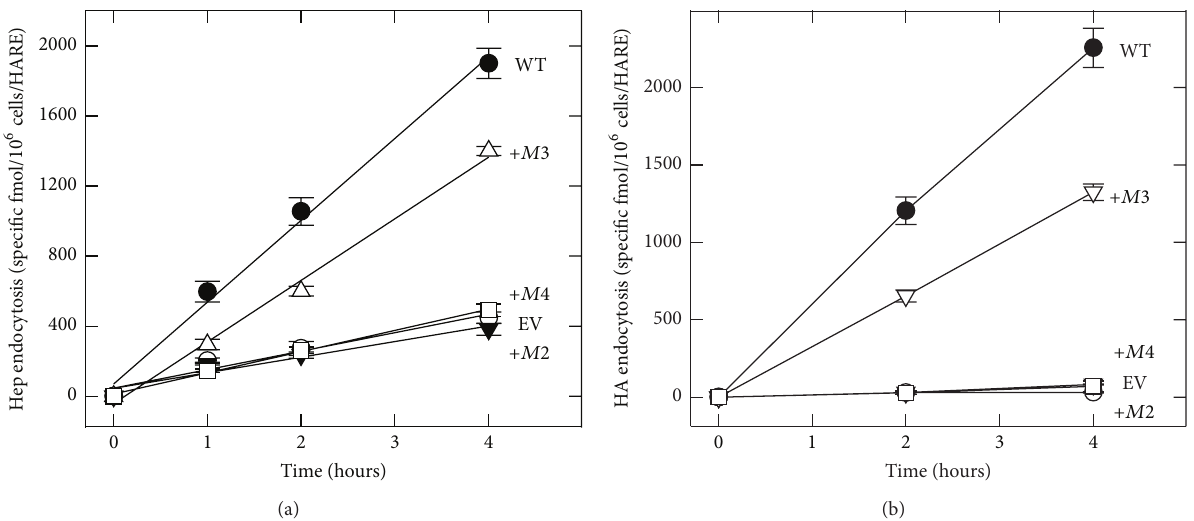
Figure 4: HARE mediates the endocytosis of HA or Hep in the presence of M3 alone, but not in the presence of M2 or M4 alone. Cells expressing WT HARE ( e ), EV ( I ), or single-motif containing HARE CD variants + M2 ( 󳶃 ), + M3 ( Δ in (a); 󳶋 in (b)), or M4 ( ◻ ) were grown and treated as in Figure 2, incubated at 37 ∘ C for the indicated times with 125 I-labeled Hep (a) or HA (b), and processed to quantify uptake as described in Methods section . Values are means ± SE ( 𝑛 = 9 ) and all linear regression lines had correlation coefficients ≥ 0.97. The three symbols for EV, + M2, and + M4 cells overlap at essentially identical positions in the bottom lines of each